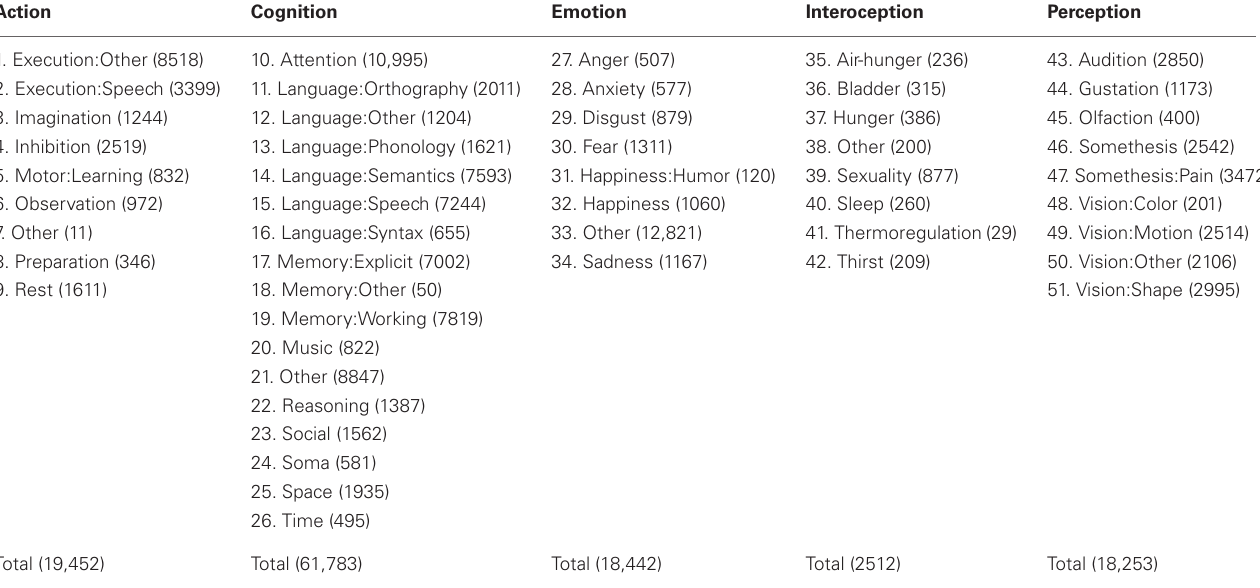
Table 1 | BrainMap behavior categorization by domain and sub-domain.